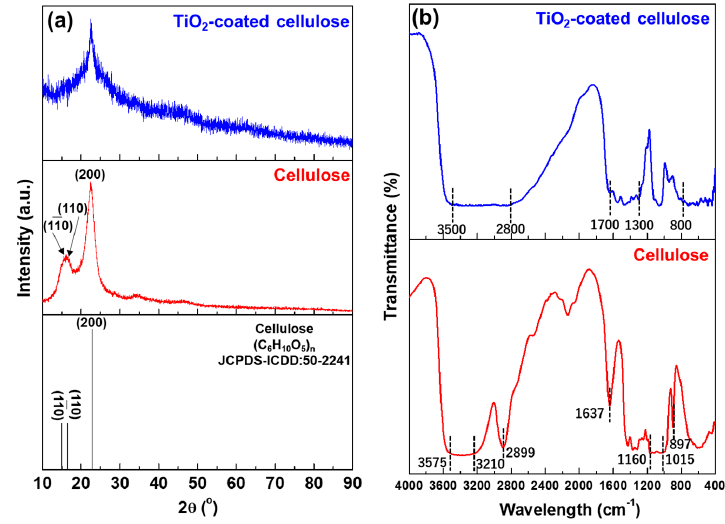
Figure 1. ( a ) XRD patterns and ( b ) FT-IR spectra of the cellulose nanofibers before and after the TiO 2 coating.